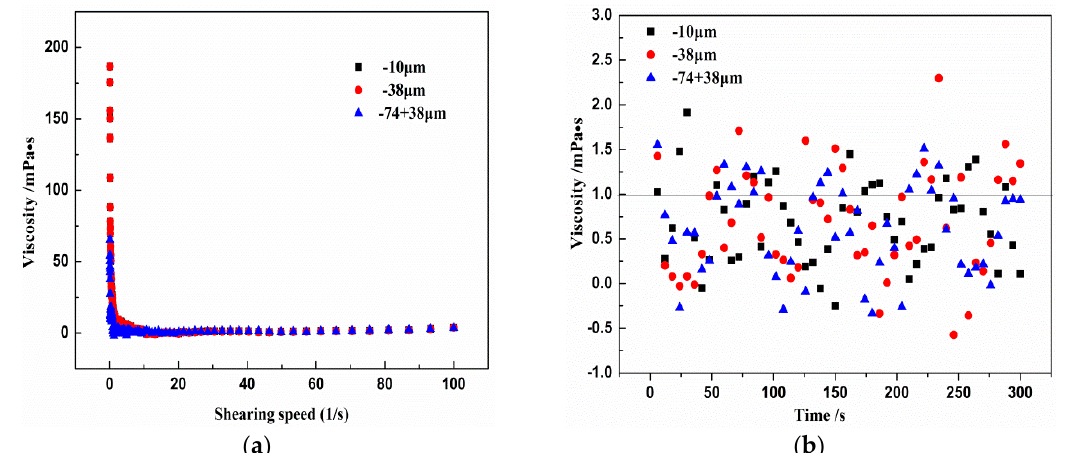
Figure 3. The viscosity results for different size fractions with respect to the conditions of ( a ) shearing speed and ( b ) time.